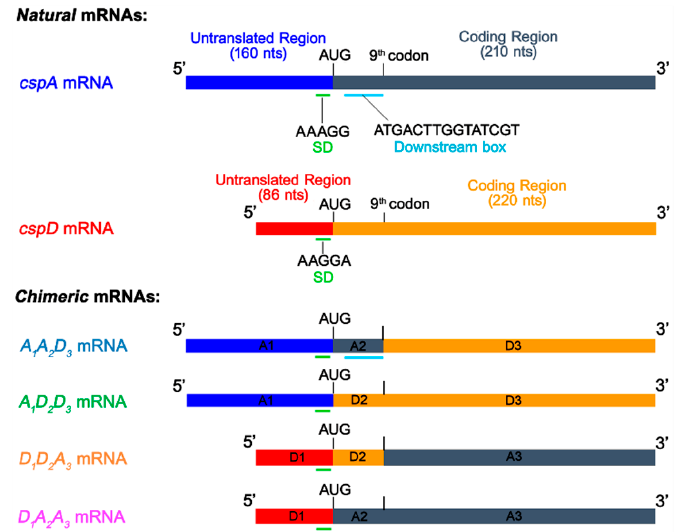
Figure 1. Schematic representation of the mRNAs prepared and used in this study. The two original mRNAs are shown at the top of the scheme: the 5’ untranslated regions (5’UTR) of cspA (blue) and cspD mRNA (red), which represent the RNA fragments A 1 and D 1 , respectively, and the coding regions of cspA (dark gray) and cspD mRNA (orange) are colour coded. Also indicated are the positions of initiation triplets, SD sequence and downstream box (DB) as well as the position of the 9 th codon which represents the A 2 /A 3 and D 2 /D 3 borders between the RNA fragments derived from cspA and cspD , respectively. The lower part of the scheme shows the four mRNAs constructed by swapping the three RNA fragments (A 1 A 2 A 3 and D 1 D 2 D 3 ) of the mRNA to construct the chimeric mRNAs indicated on the left side of the figure. The construction of the chimeric mRNAs is described in Materials and Methods.